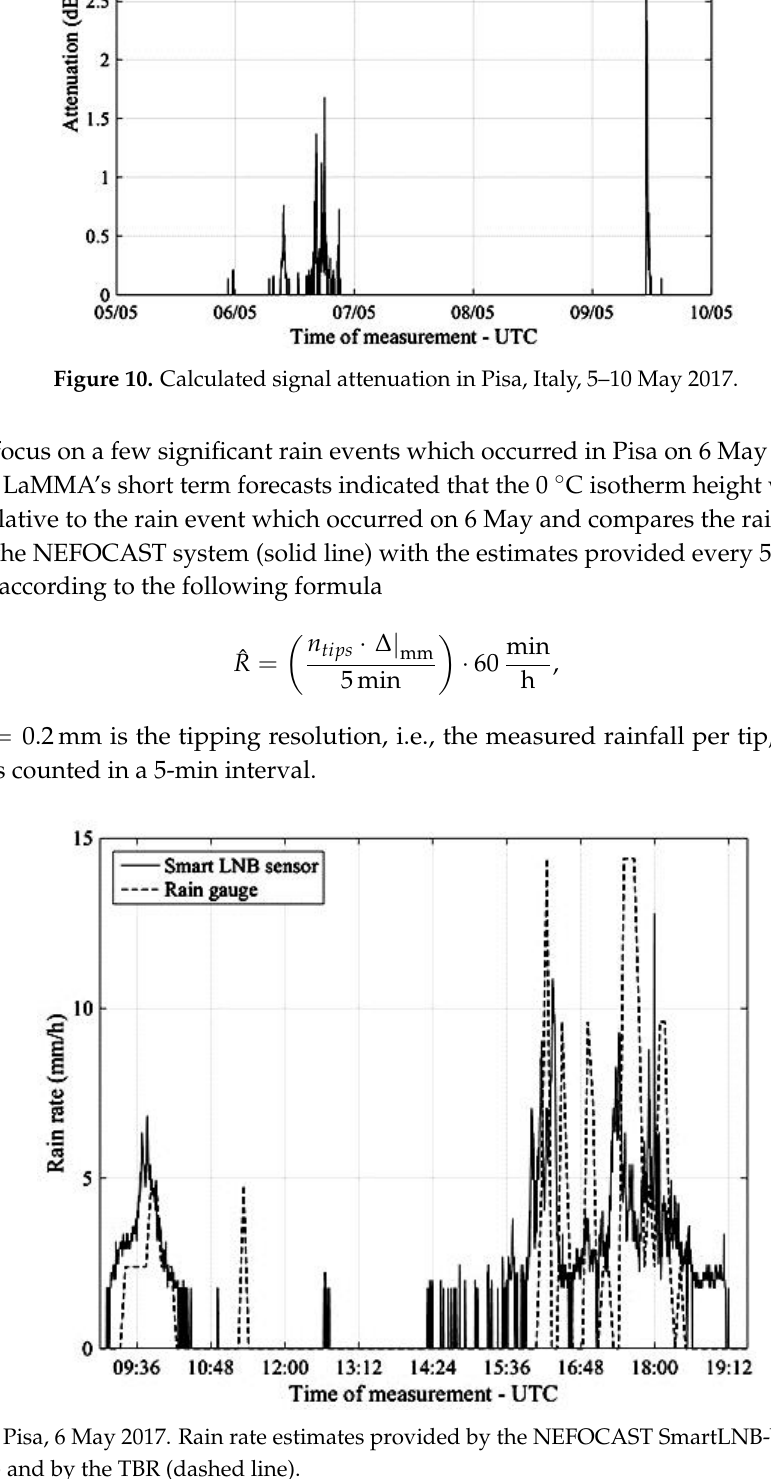
Figure 12. Pisa, 9 May 2017. Rain rate estimates provided by the NEFOCAST SmartLNB-based sensor (solid line) and by the TBR (dashed line).